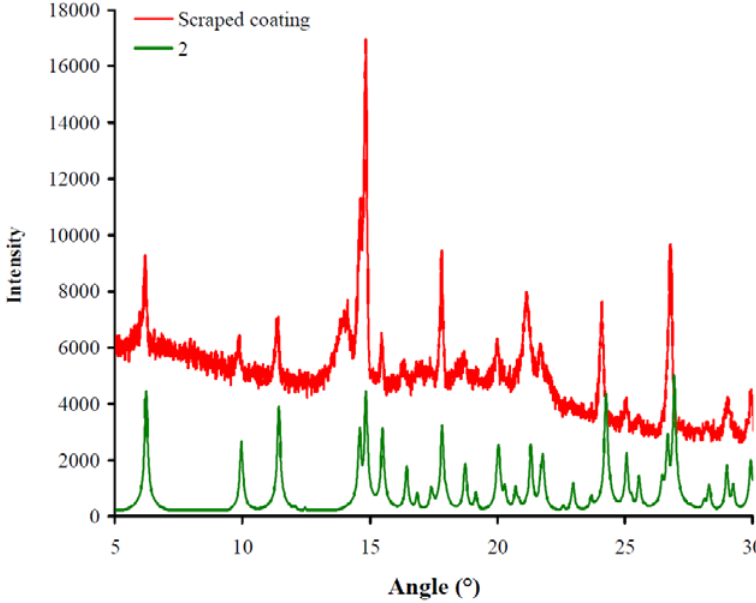
Figure 2. X-ray powder diffraction spectra of silver(I) compound onto the modified gold surface. The scraped coating (in red) was compared with the silver(I) compound 2 from the literature (in